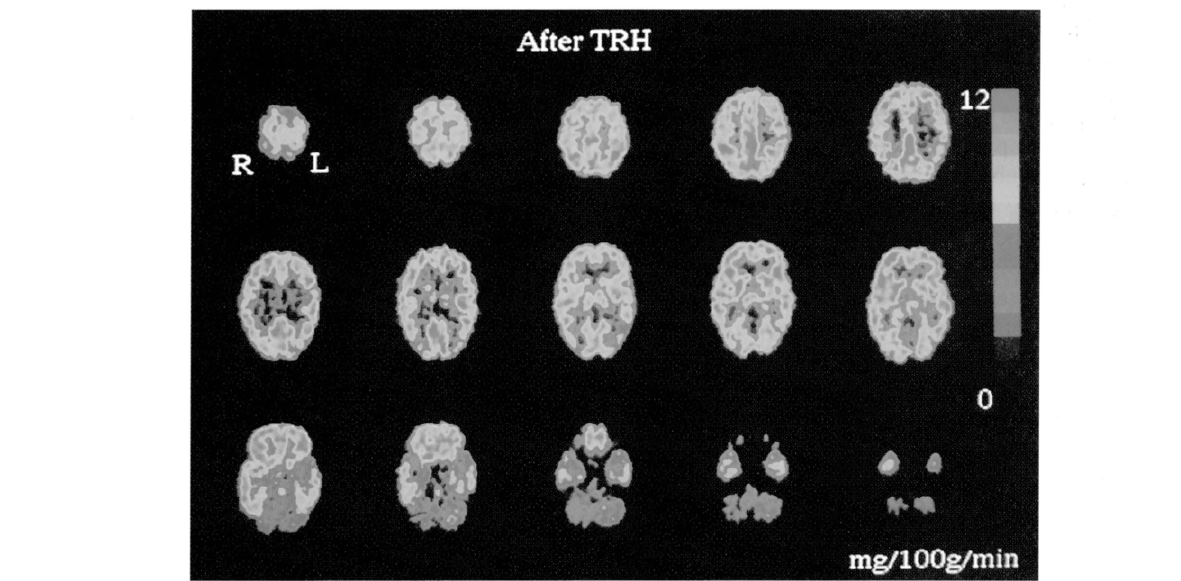
FIG. 3. PET images of the metabolic rate for glucose 3 weeks after the TRH treatment. A marked decrease of CMRGlc in the cerebellum was still observed.